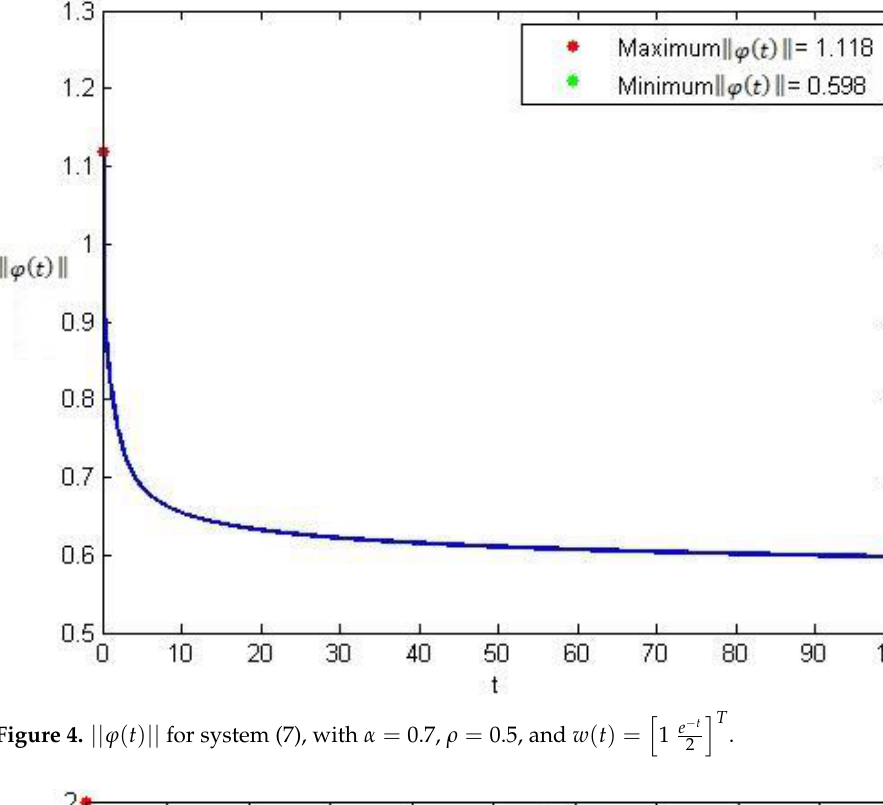
Figure 4. ‖𝜑(𝑡)‖ for system (7), with 𝛼 = 0.7 , 𝜌 = 0.5, and 𝑤(𝑡) = [1 𝑒